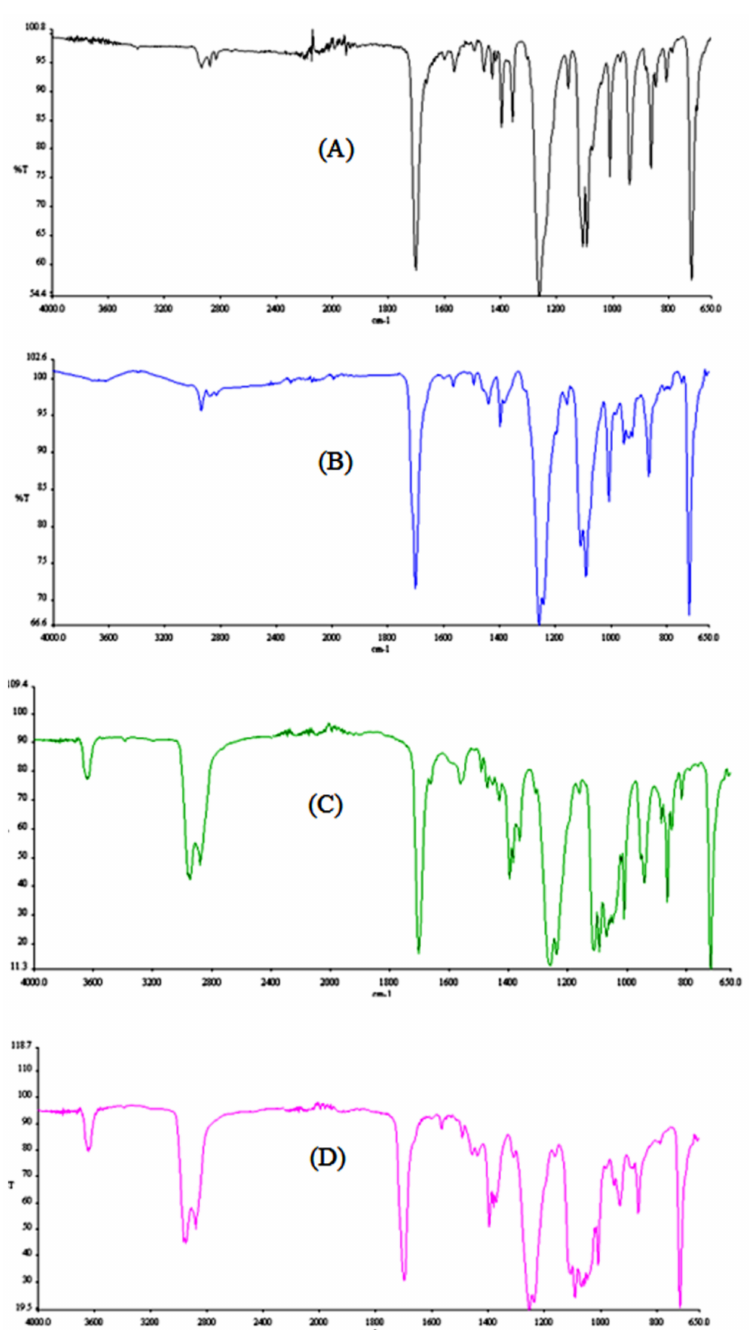
Figure 5. Fourier transform infrared (FTIR) spectra of the isolated PBT cyclic oligomers isolated ( A ) dimer; ( B ) trimer; ( C ) tetramer and ( D )